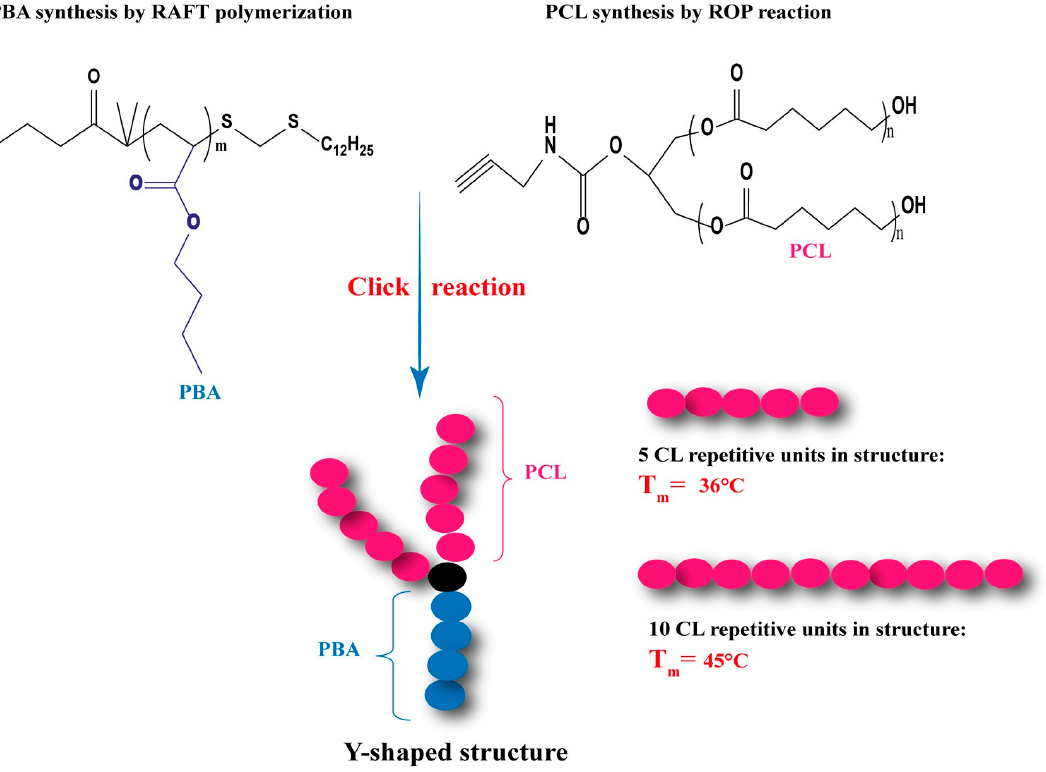
Figure 5. The Evolution of Melting Temperature (Tm) of PCL Blocks with CL Repetitive Units in Y-Shaped Structures.